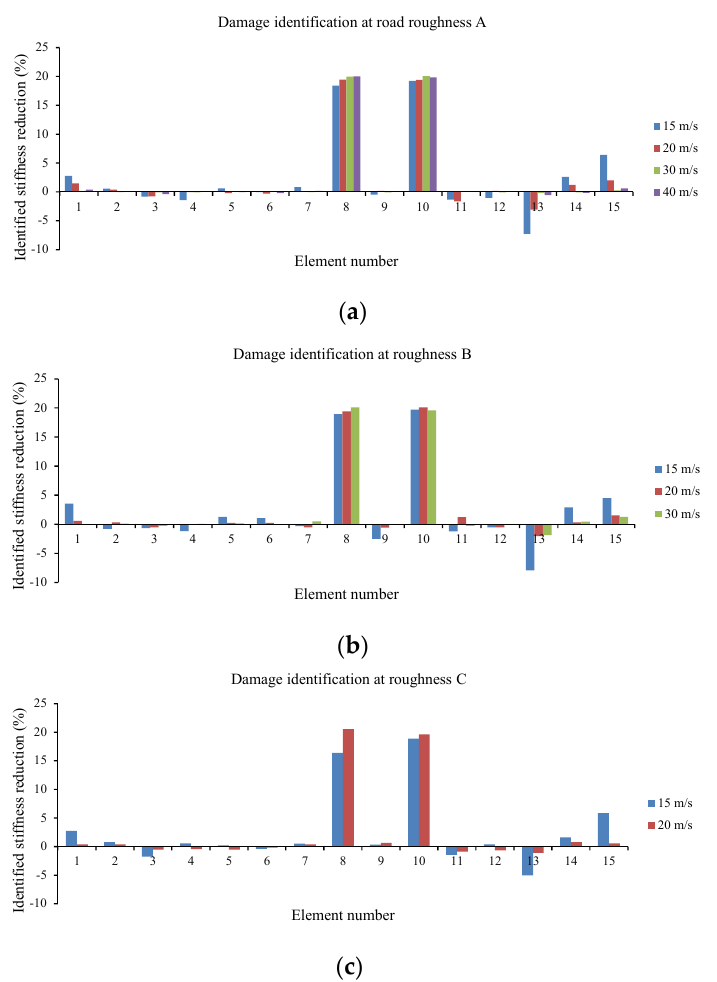
Figure 5. Effect of speed at road roughness levels A to C (0% noise). ( a ) roughness A; ( b ) roughness B; ( c ) roughness C.